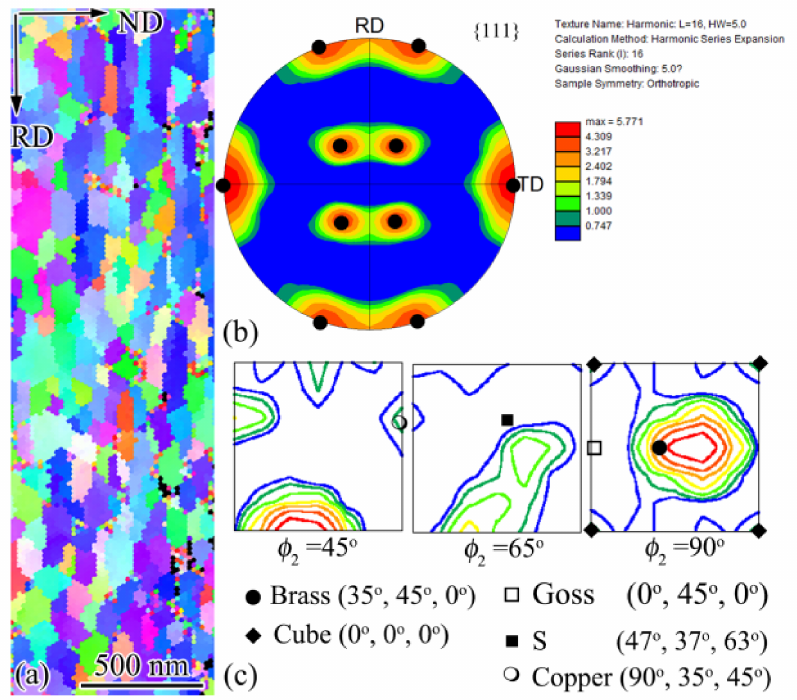
Figure 14. TKD analysis of the ultrafine laminated structure on the surface layer in USRT AISI 304 stainless steel sample: IPF image ( a ); {111} pole figure ( b ); and ODF plots for φ 2 = 45 ◦ , 65 ◦ , and 90 ◦ , respectively ( c ). Typical rolling texture components, i.e., Brass, Goss, Cube, S, and Copper were inserted for comparison. Note that UFL shows typical Brass-type rolling